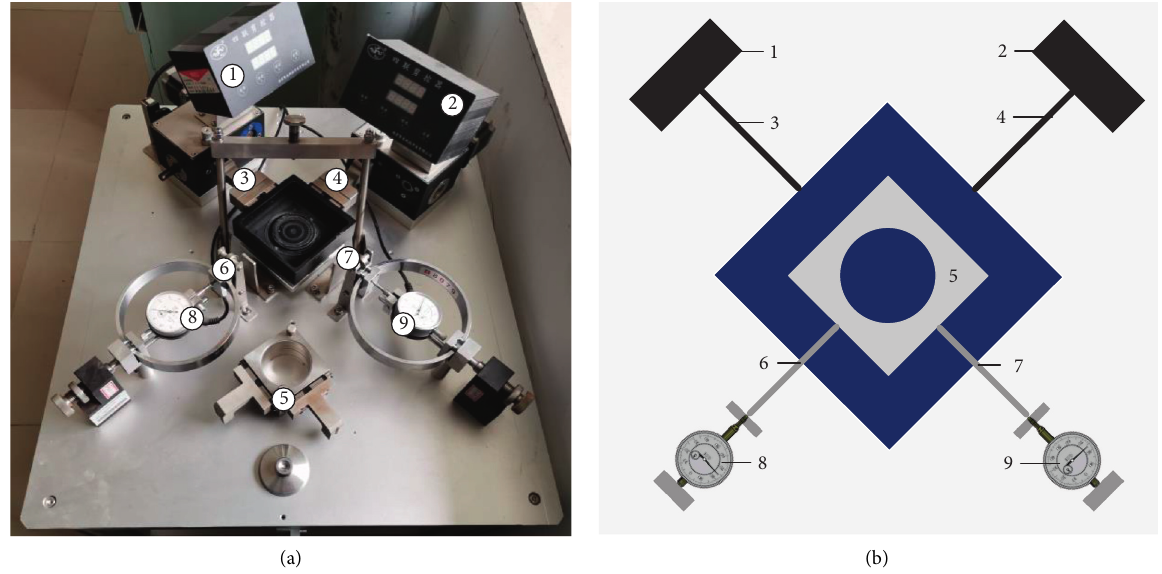
Figure 2: Top view of three-dimensional direct shear apparatus. (a) Picture of the apparatus. (b) Schematic view of the apparatus.